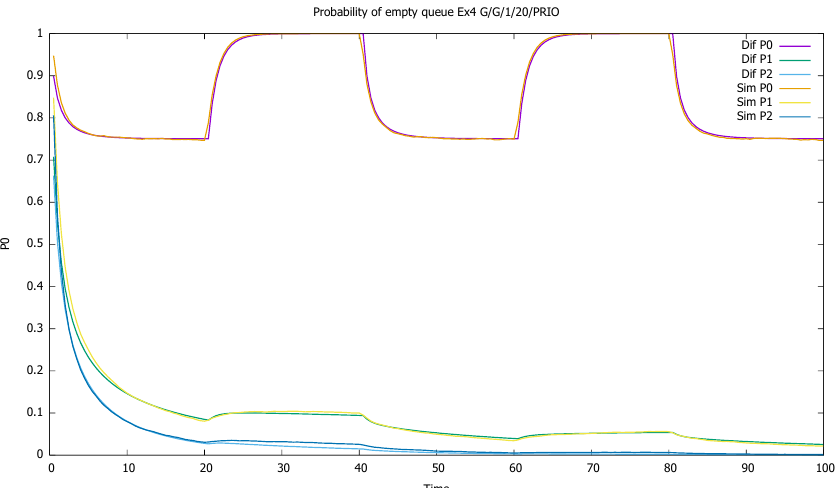
Figure 15. Section 3.4, three priorities; probabilities of empty queues as a function of time for three priority classes (P0), (P1), (P2).